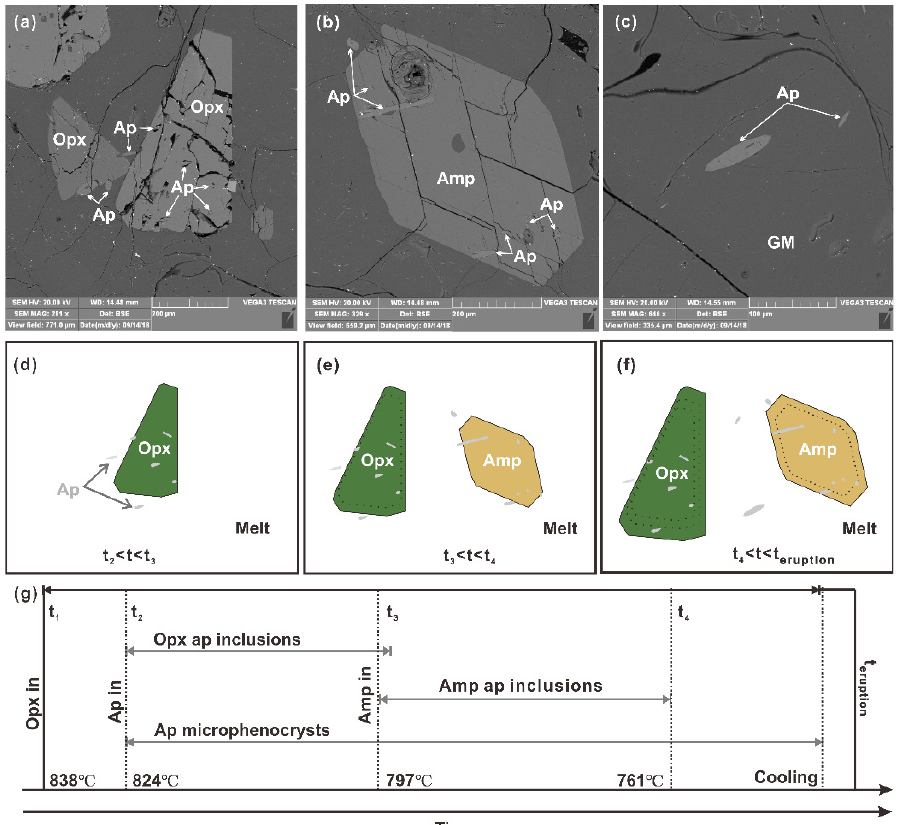
Figure 2. Backscattered-electron (BSE) images displaying orthopyroxene ( a ) and amphibole ( b ) phe- nocrysts, and apatite microphenocrysts ( c ). ( d – f ) Sketch map showing the progressive growth of orthopyroxene and amphibole with the entrapment of apatite inclusions through time during cooling; ( g ) t1–t3 refer to the onset of crystallization of minerals (opx-in, ap-in, and amp-in), while t4 refers to the end of the crystallization of amphibole. The crystallization temperatures of minerals are according to previous studies [36,39]. Ap, apatite; Opx, orthopyroxene; Amp, amphibole; GM,